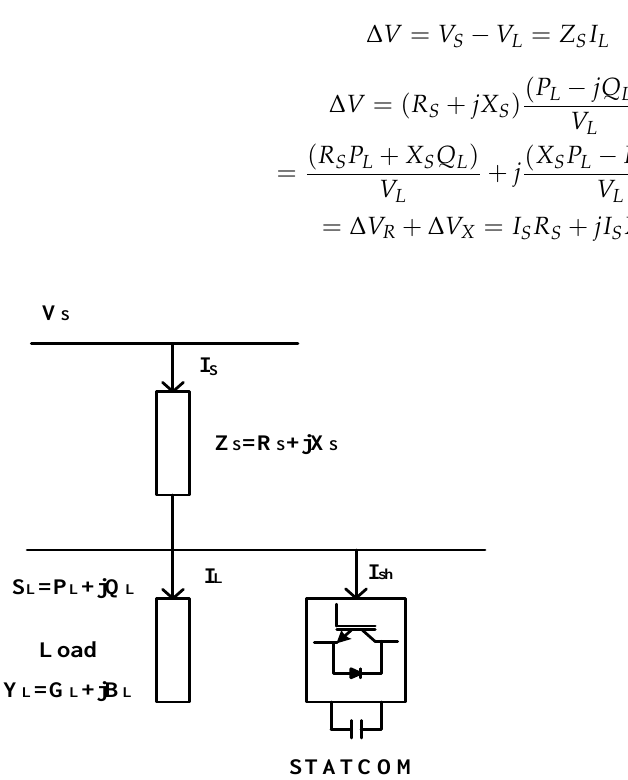
Figure 1. Principle of STATCOM voltage stability improvement. Figure 2 is a vector diagram of voltage drop ∆ V caused by the line impedance Z S